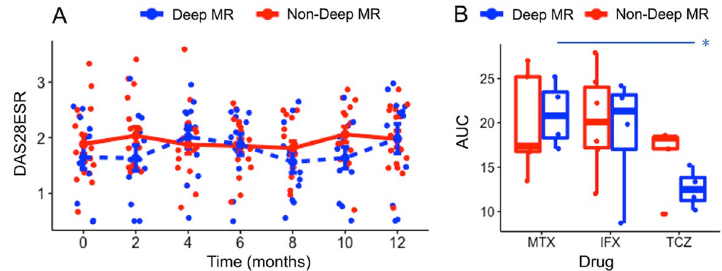
Figure 5. Relationship between MR and disease activity. ( A ) The changes in DAS28-ESR during the follow-up period, which was split into two-week intervals. For each group, the average ± standard error of DAS28-ESR within the same interval was shown by the line. ( B ) Comparison of AUC (commutative DAS28-ESR during the 12-month follow-up) according to drug type. ‘*’: p < 0.05. AUC, area under the curve; DAS28-ESR, disease activity score-28 ESR; IFX, infliximab; MTX, methotrexate; TCZ,